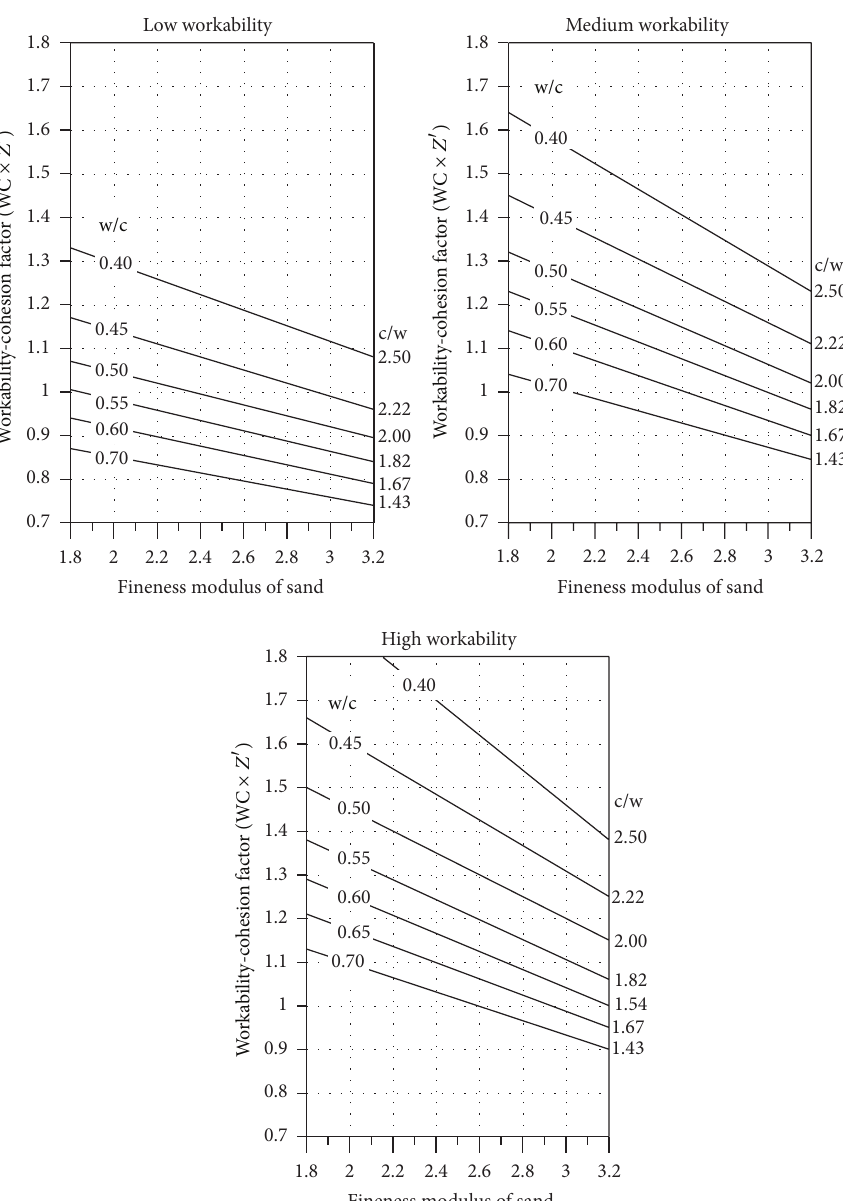
Figure 3: Relationship between fineness modulus, cement water ratio (w / c ratio), and workability-cohesion